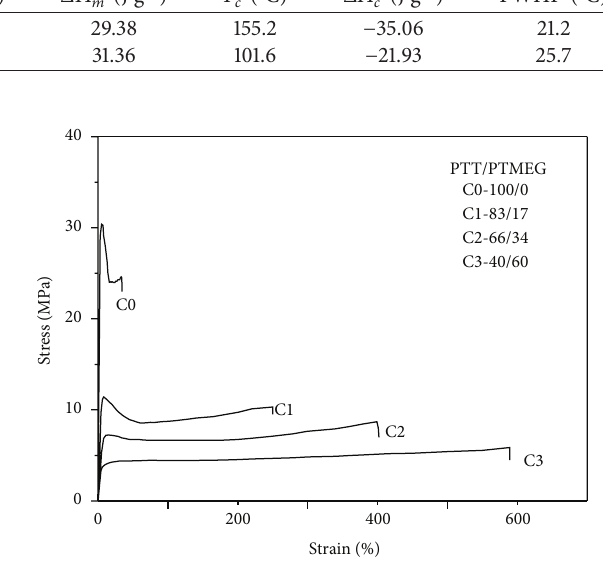
Figure 9: The stress-strain properties of PTT-PTMEG